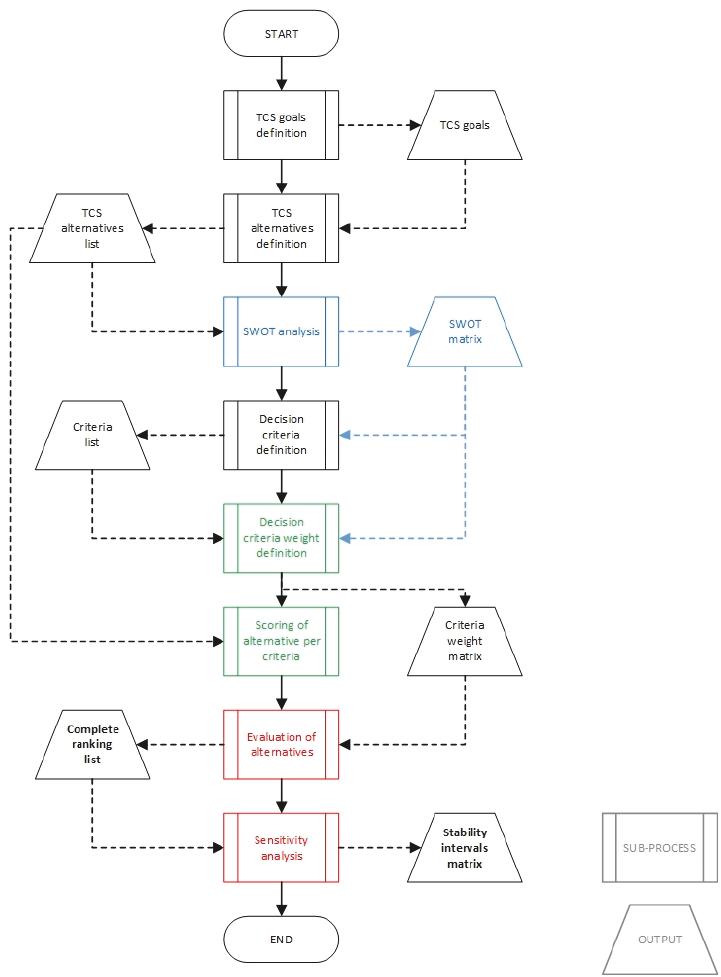
Figure 2: Proposed decision-support